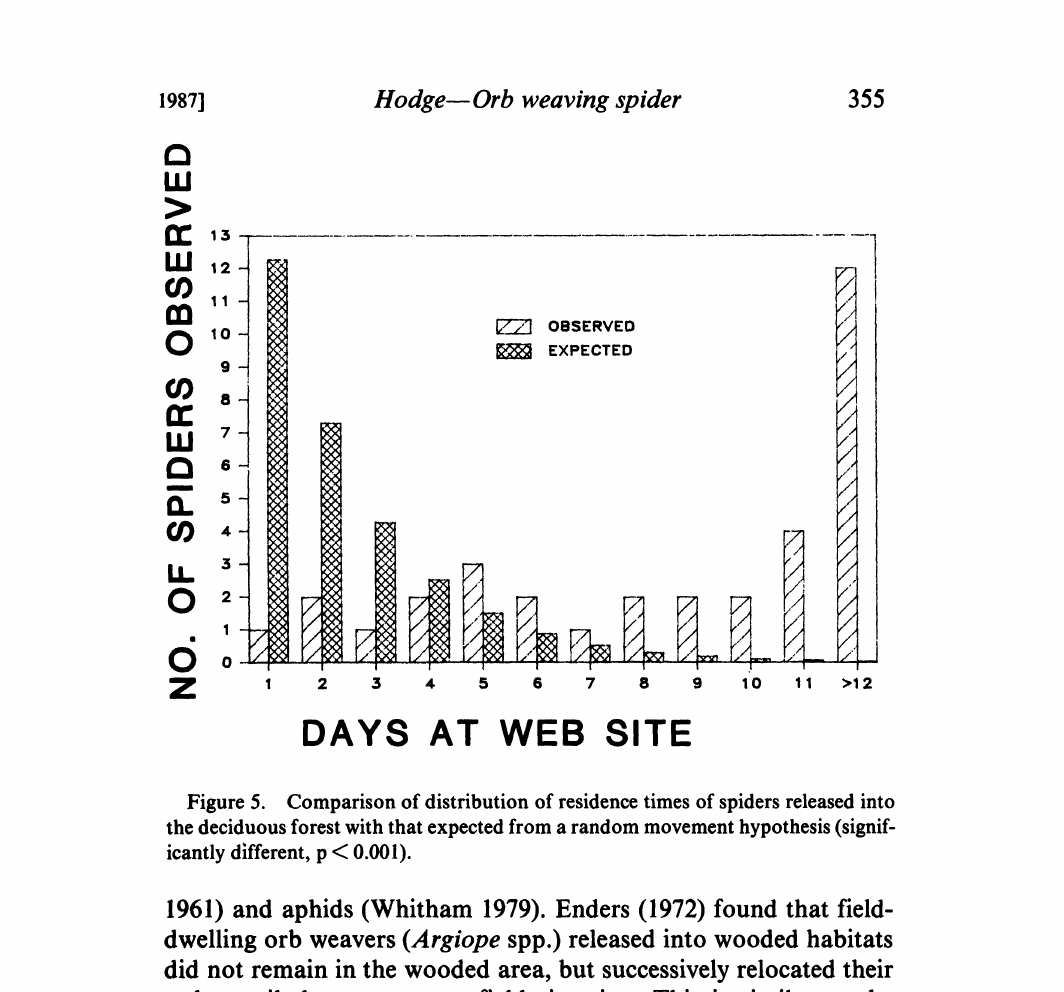
Figure 5. Comparison of distribution of residence times of spiders released into the deciduous forest with that expected from a random movement hypothesis (signif- icantly different, p <